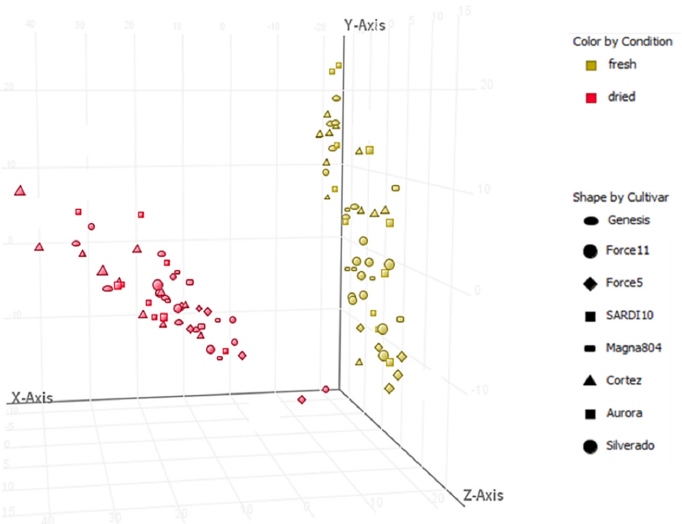
Figure 4. A visual representation of a 3D PCA (principal component analysis) of the molecular fea- tures characterized in shoot samples collected from seven cultivars of lucerne using UHPLC-QToF- MS in negative ion mode. Component 1 (X-Axis), 2 (Y-Axis) and 3 (Z-Axis) contributed to the sepa-